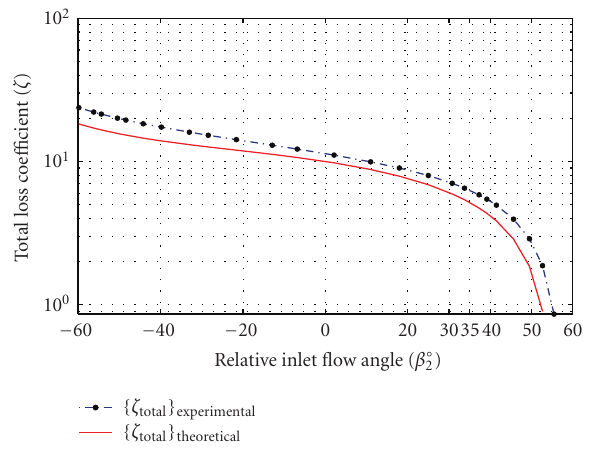
Figure 12: Turbine loss coe ffi cient versus inlet flow angle ( β 2 ) [10].